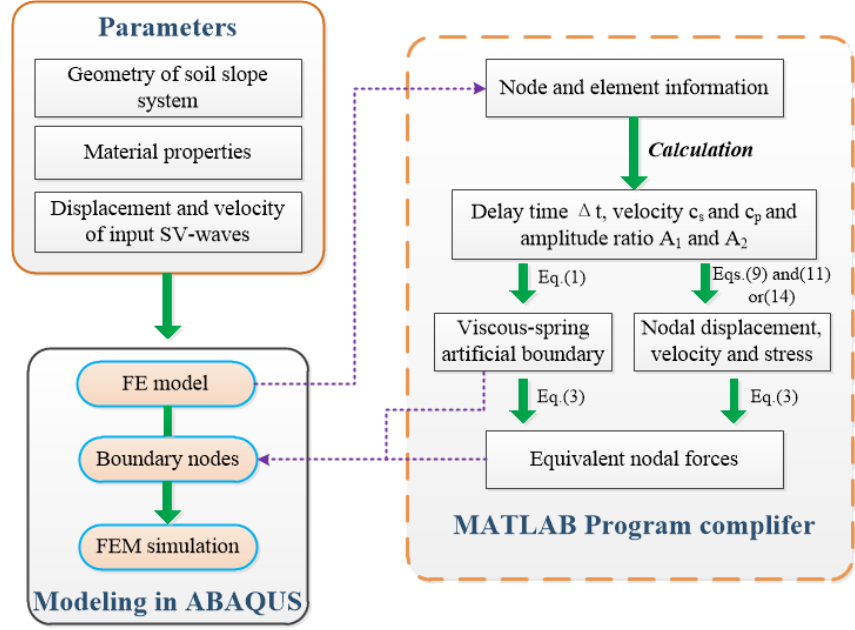
Figure 5. Flow chart for input seismic waves implemented in ABAQUS.